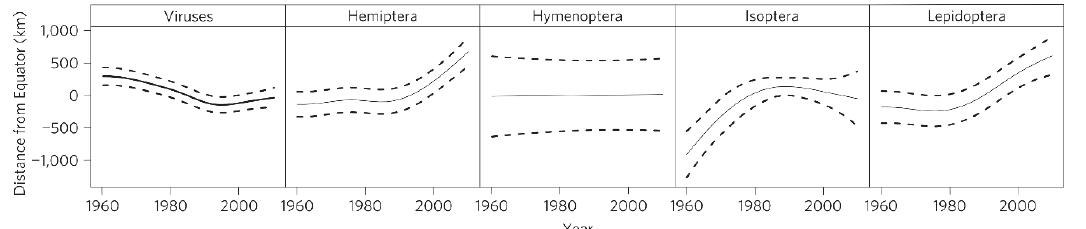
Figure 4. Poleward movements against the year of observation of plant viruses and different insect families that include relevant vectors. Redrawn with permission from